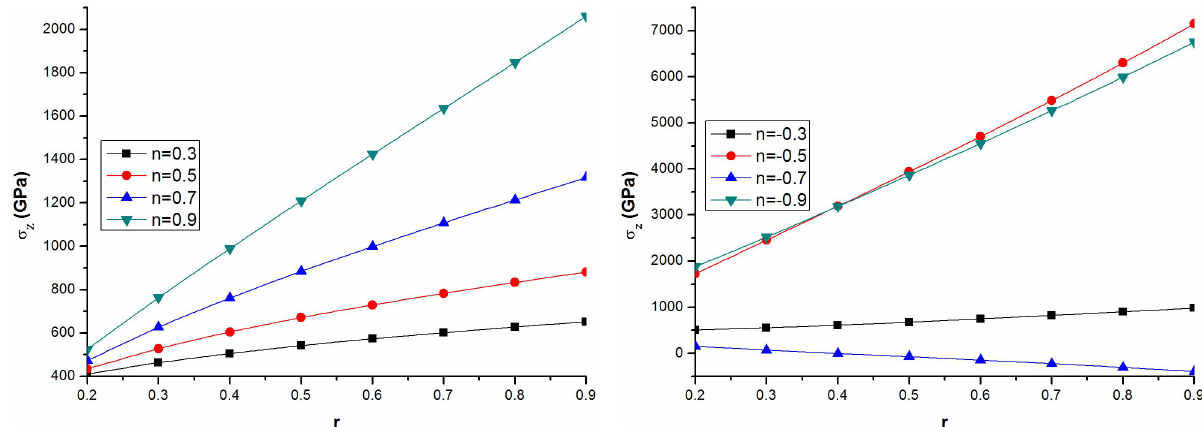
Figure 10: Axial stress versus radial coordinate for various values of n under steady state temperate distribution